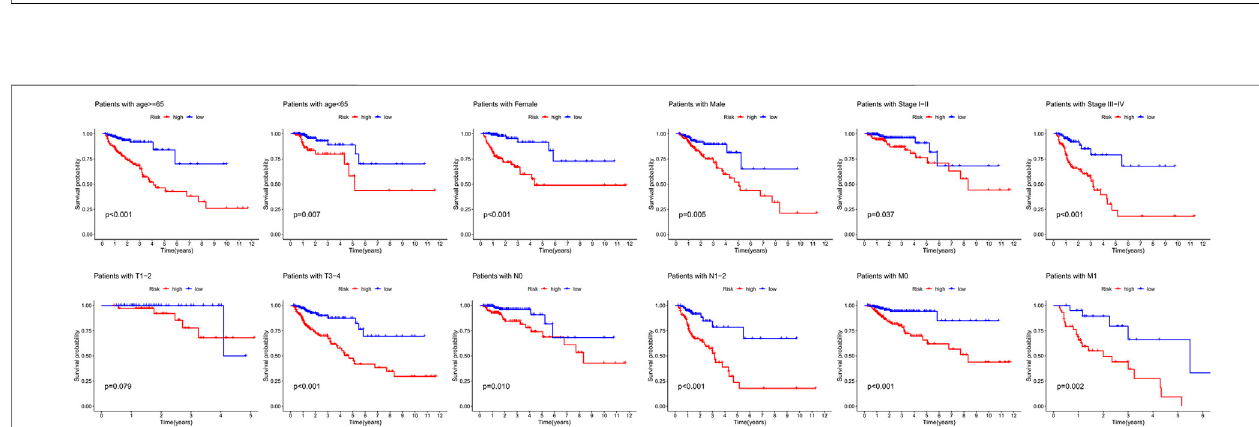
Frontiers in Genetics |